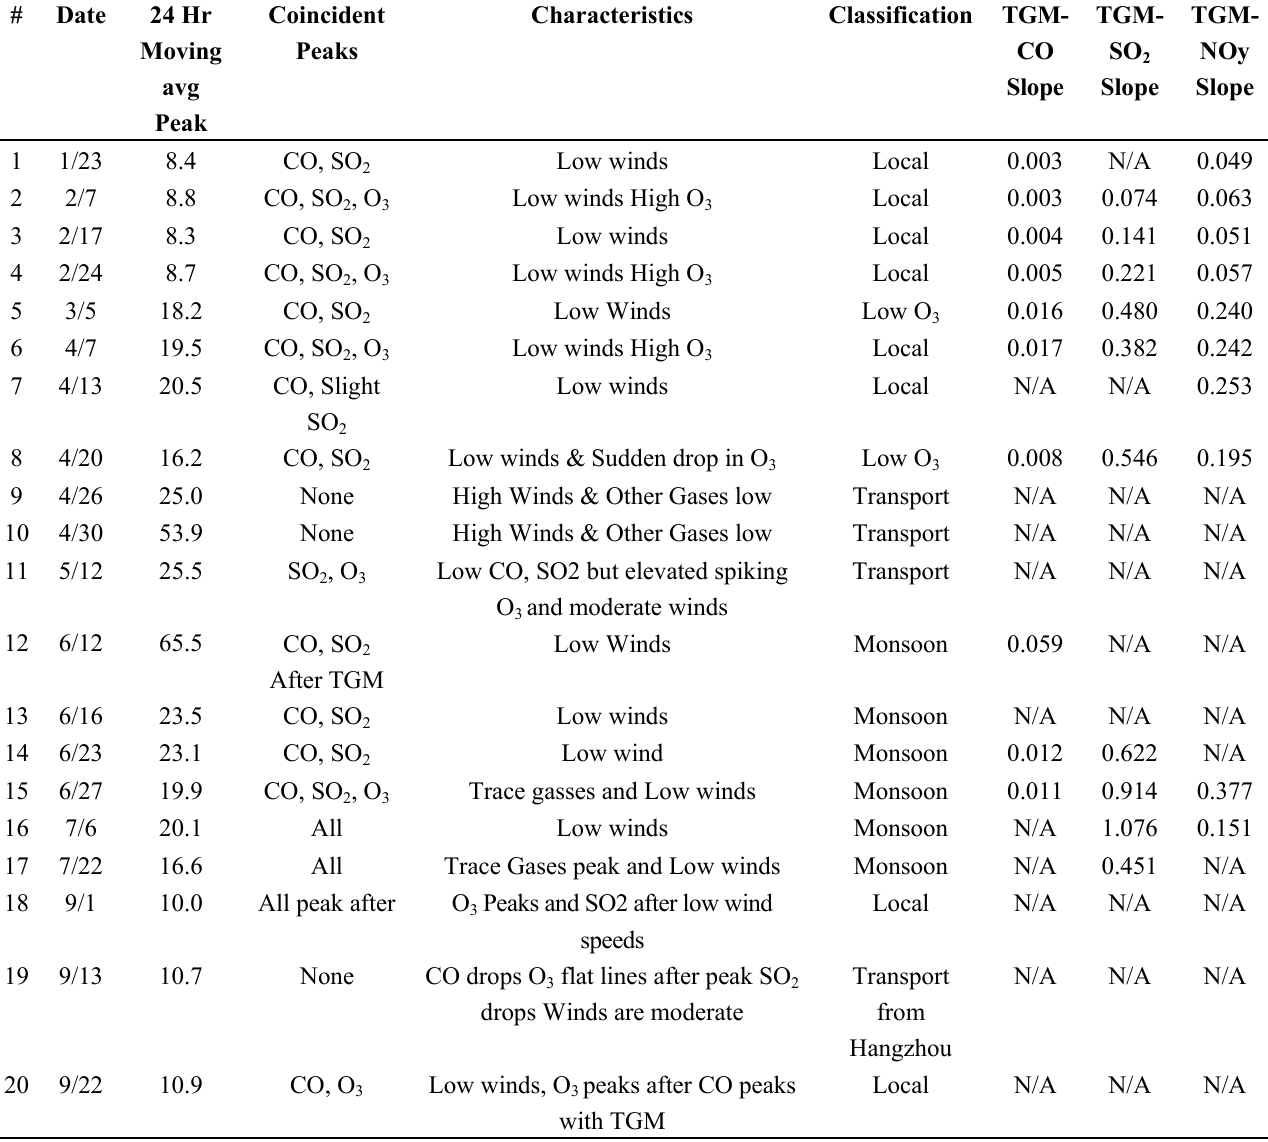
Table 1. The table contains mercury episodes in chronological order. The date of the episode is the point of the peak. The concentration in column three is the highest achieved during a 24-hour moving average. The coincident peaks were qualitatively assigned from other trace gases. The other columns are the defining characteristics of the episode, the type or classification. The last three columns are the slope of the linear regression of the trace gas vs. mercury data from the 72 hours around the episode. Only slopes of correlations with an r 2 > 0.2 and p-value < 0.001 were